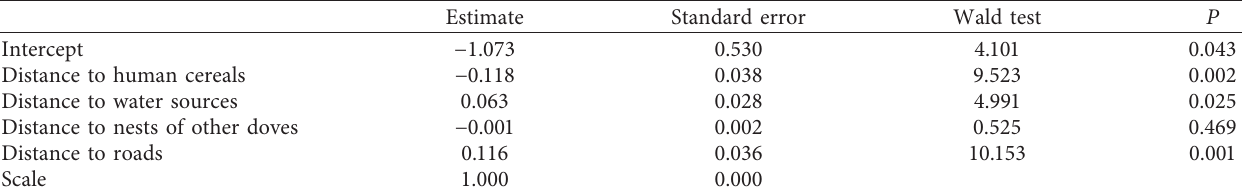
Table 4: The effect of distance separating the broods to neighboring human farms, water, nests, or roads on the probability to produce